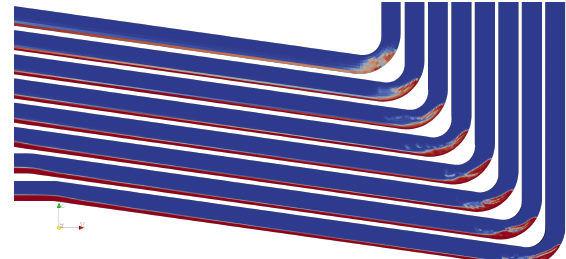
Figure 7. Longitudinal cut at y = 0 m. The coarsest mesh at upper left and finest at lower right.